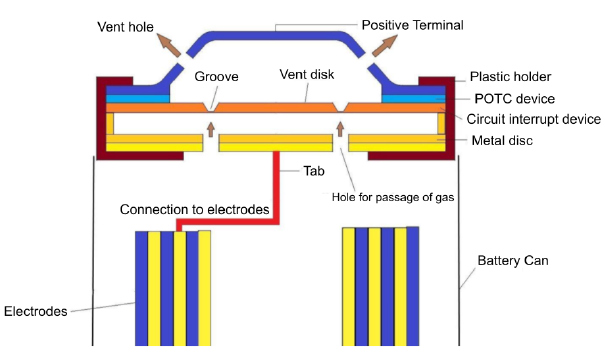
Figure 2. Schematic structure of Circuit Interrupt Device (CID), Positive Temperature Coefficient (PTC), and venting system in a cylindrical cell. Reproduced from